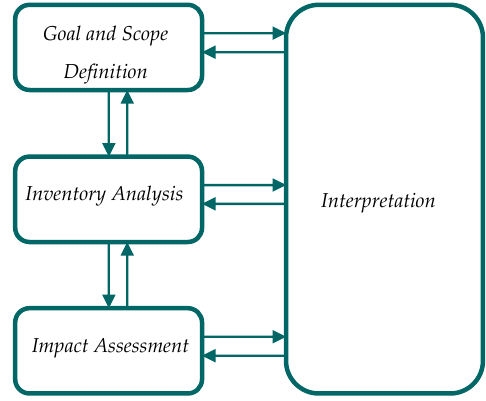
Figure 2. Life Cycle Assessment (LCA) framework, adapted from ISO 14040 [12].